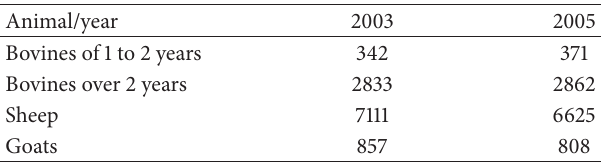
Table 2: Estimated livestock intended for breeding in Castelo de Vide. Animal/year 2003 2005 Bovines of 1 to 2 years 342 371 Bovines over 2 years 2833 2862 Sheep 7111 6625 Goats 857 808 (Source: model